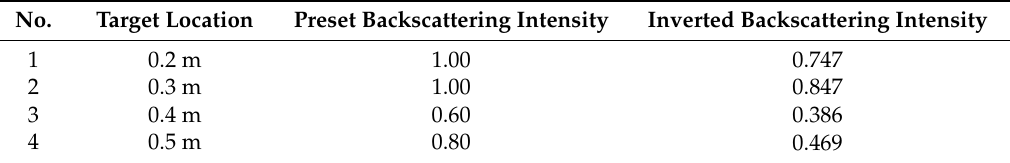
Table 1. Inversion of the multi-target